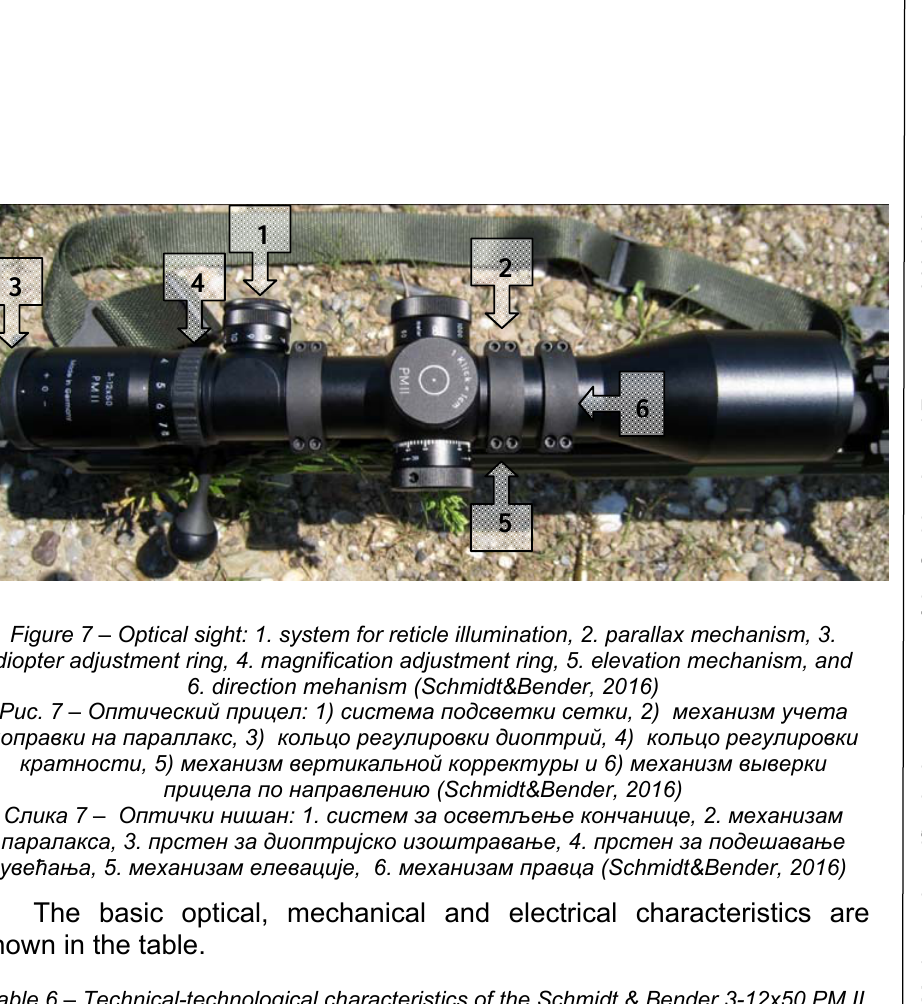
Table 6 – Technical-technological characteristics of the Schmidt & Bender 3-12x50 PM II P optical sight (Schmidt&Bender, 2016), (Serbian Armed Forces,